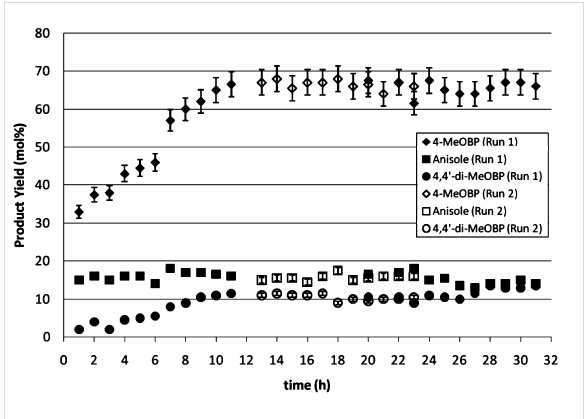
Figure 6: Kumada reaction carried out in a parallel channel meso reactor over a 31-hour period at a flow rate of 95 ml h −1 to show cata- lyst stability and